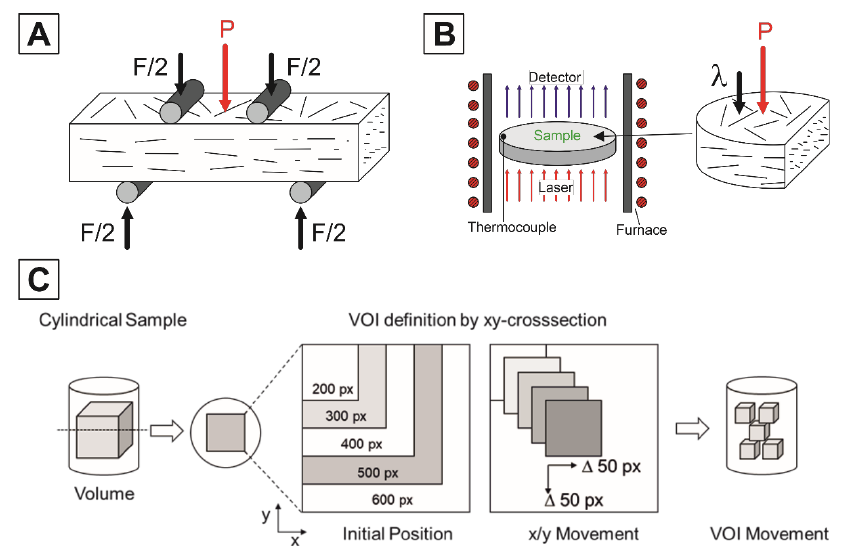
Figure 2. Schematic characterization techniques utilized to determine the physical properties considering the sample orientation and fibrous pore alignment: flexural strength determined by 4-point bending ( A ), thermal conductivity by laser-flash analysis ( B ), and the definition of the analyzed Volume-of-Interests based on the increasing and shifting arguments of the starting volume used for the µCT-analysis ( C ). Table 1. Compositions and corresponding target and total porosities of the realized alumina ceramics with monomodal, bimodal, and trimodal mixtures of sacrificial templates. Batch No.